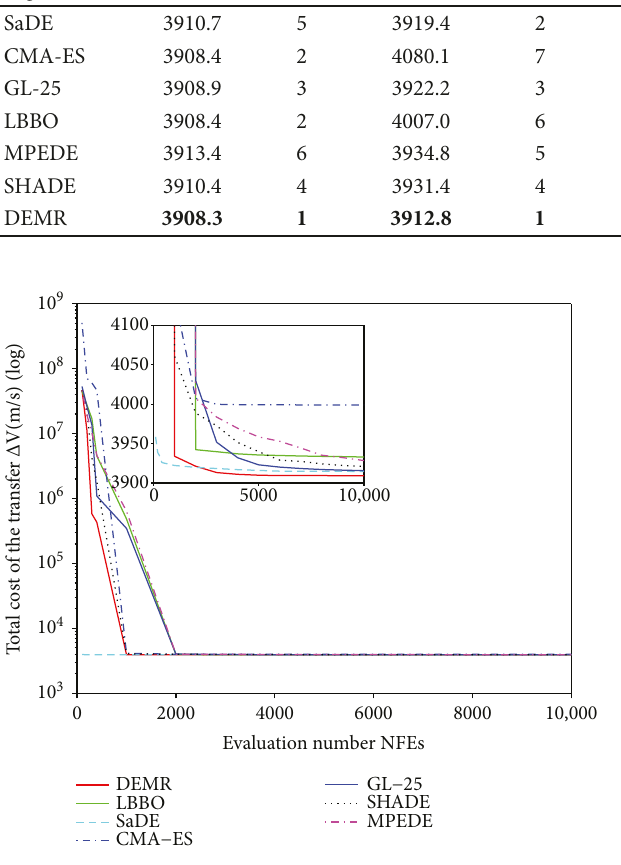
Figure 3: The convergence graph of the algorithms on the Earth- Moon low-energy transfer trajectory optimization problem.